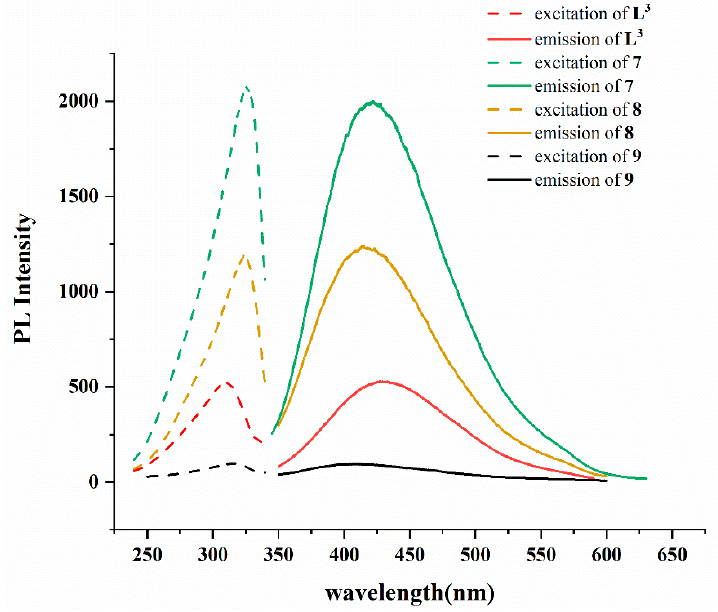
Figure 8. Excitation and emission spectra of complexes 7–9 and L 3 . Table 5. Luminescent properties of 7 – 9 .